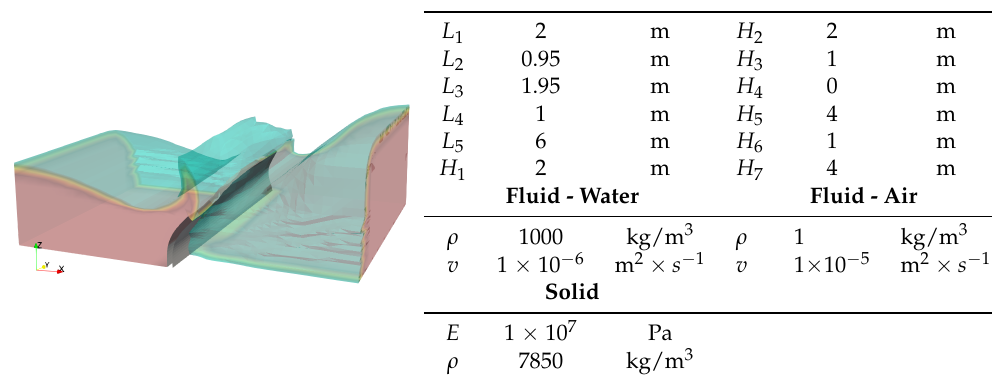
Figure 5. Breaking-Dam-3D waters striking the flexible wall at 0.75 s ( left ) and dimensions and material parameters ( right